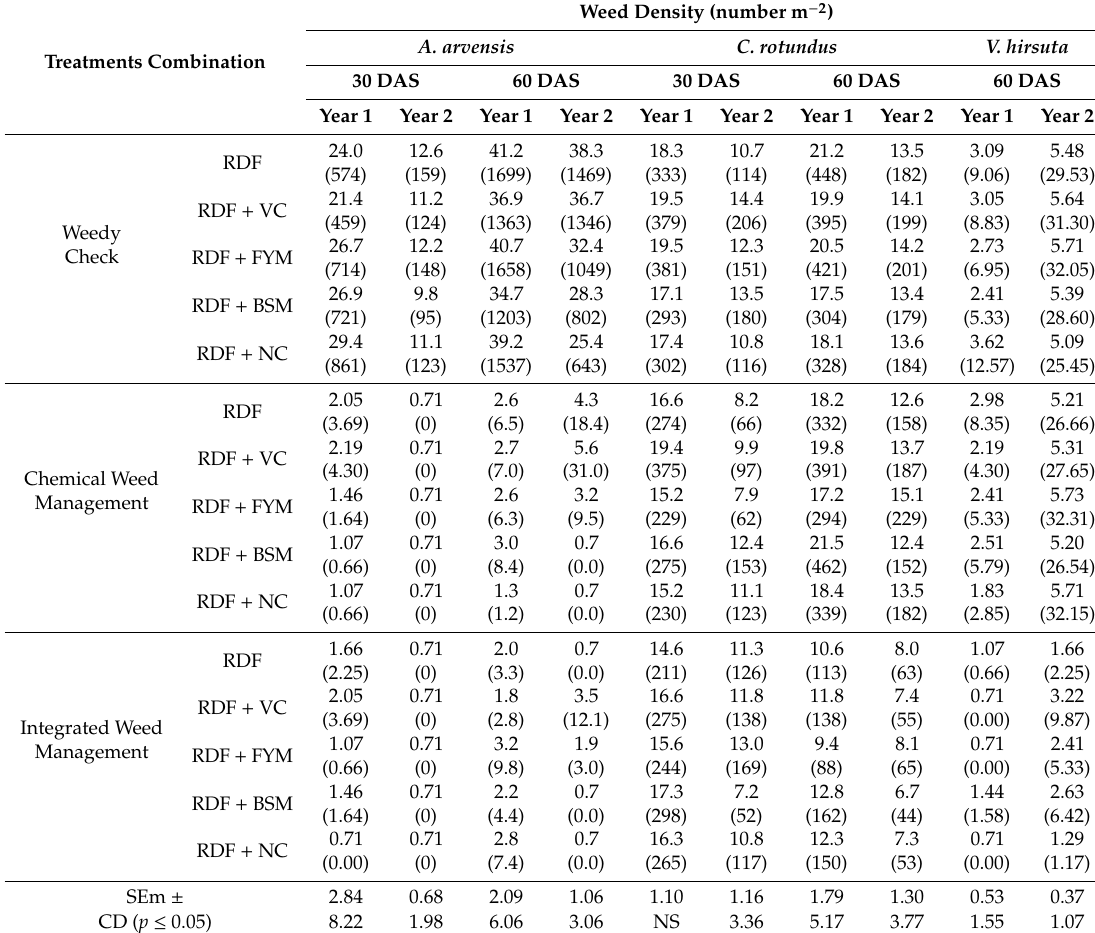
Table 1. Interaction e ff ect of di ff erent nutrient sources and weeding regimes on weed density (number m − 2 ) in hybrid